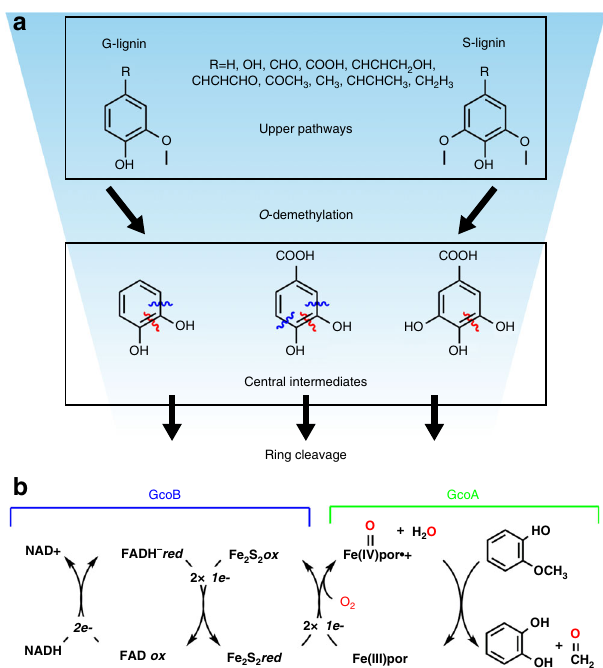
Fig. 1 O -demethylation in aromatic catabolism. a O -demethylation provides a central role in the upper pathways of aromatic catabolism 5,6,76 – 80 . G- and S-lignin, the primary units in lignin, are O -demethylated to form central intermediates. These are then cleaved by intradiol (red lines) or extradiol (blue lines) dioxygenases. b Coupled reactions catalyzed by GcoA